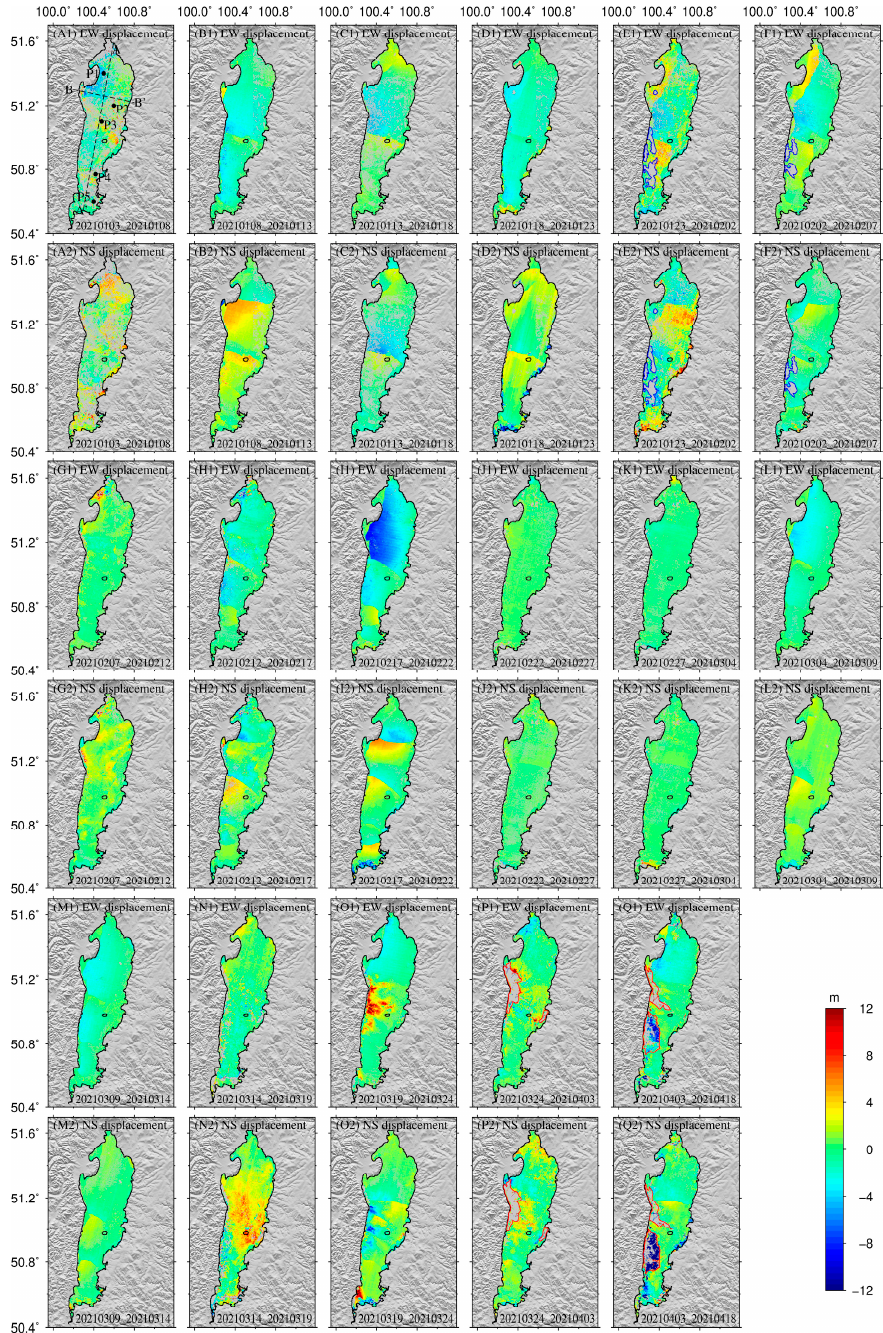
Figure 6. ( A1 – Q2 ) represent the horizontal displacement results of the surface of Lake Khovsgol in the EW and NS directions in the second stage. It is superimposed on 3 Arc-Second Global SRTM Digital Elevation Model (DEM) with 90 m resolution. The points P1–P5 and the dashed lines AA’ and BB’ in ( A1 ) are used for the specific displacement analysis in Section 4.2. The area marked by the dashed blue line in the figure is the missing signal due to cloud cover occlusion. The red line marked is caused by the ice and snow mixture. Displacement values are positive for the eastern and northern directions.